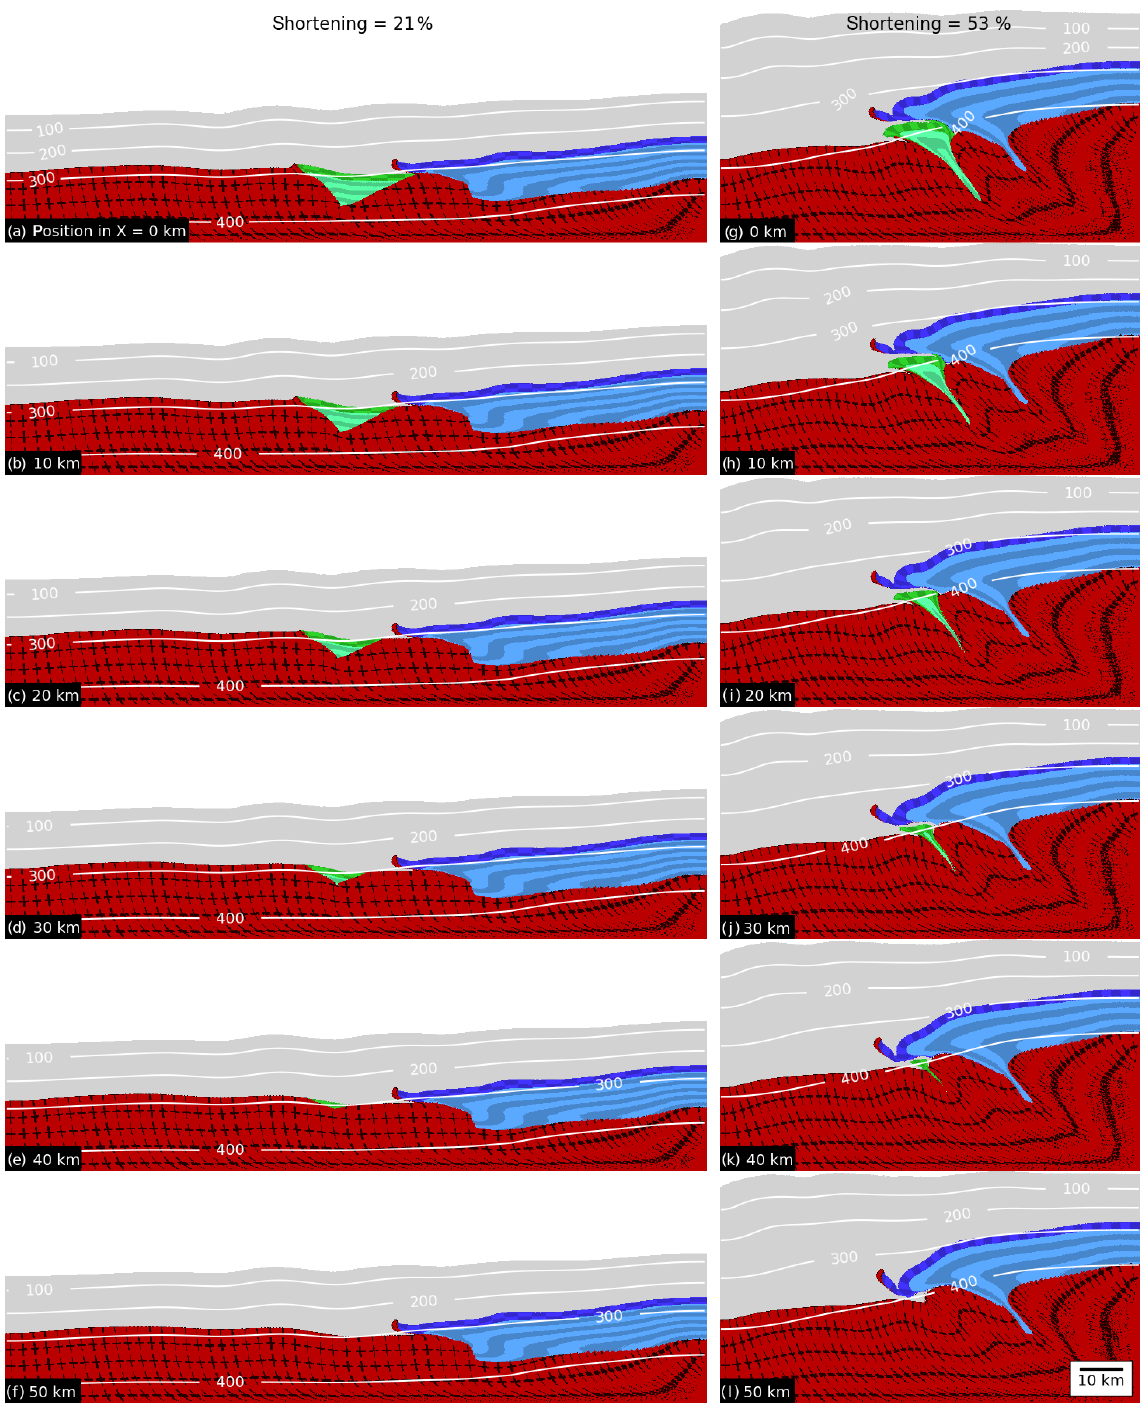
Figure 11. Graph showing lateral cross sections for two different states of bulk shortening for the geometrical evolution of model D.G-1. Cross sections are taken in 10km steps from X = 0 to X = 50km. Additionally, we display the isothermal lines in degrees Celsius ( ◦ C). Columns correspond to the bulk shortening state and rows to cross-section X